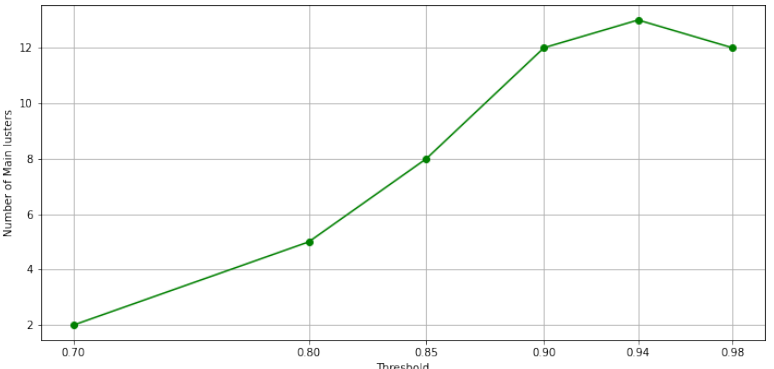
Figure 11. The number of main clusters in each ensemble solution is shown in this figure, based on the filtering method.